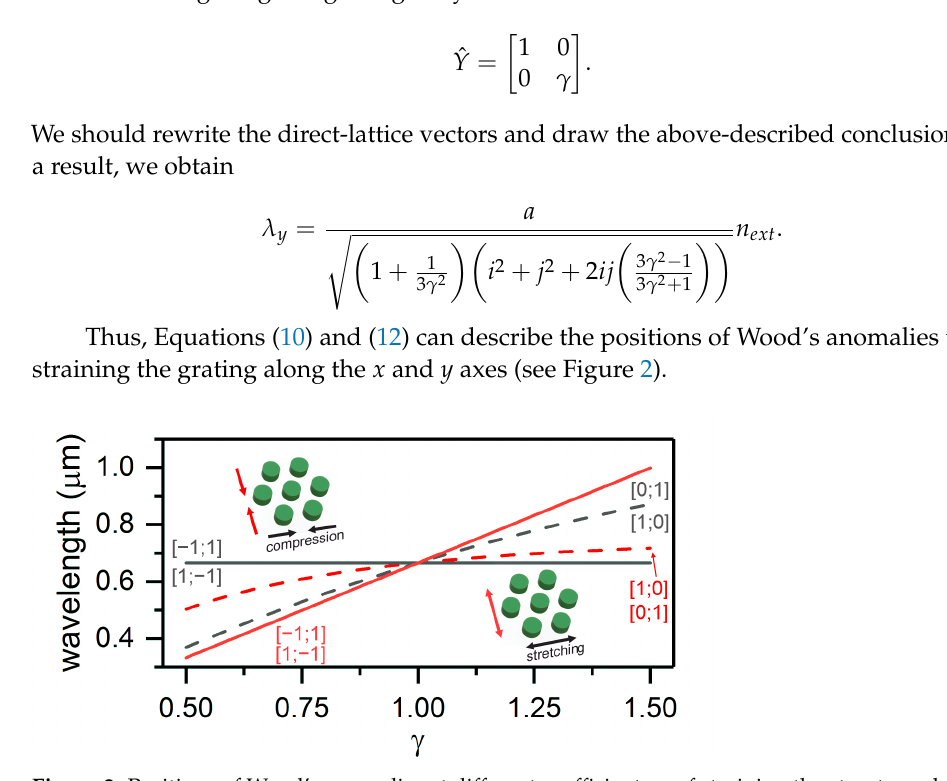
Figure 2. Positions of Wood’s anomalies at different coefficients γ of straining the structure along the x and y axes. The regions with γ < 1 correspond to the compressed structure, and the regions with γ > 1 correspond to the extended one. The notations [0;1], [1;0], and [ − 1;1], [1; − 1] correspond to different values of the indices i and j